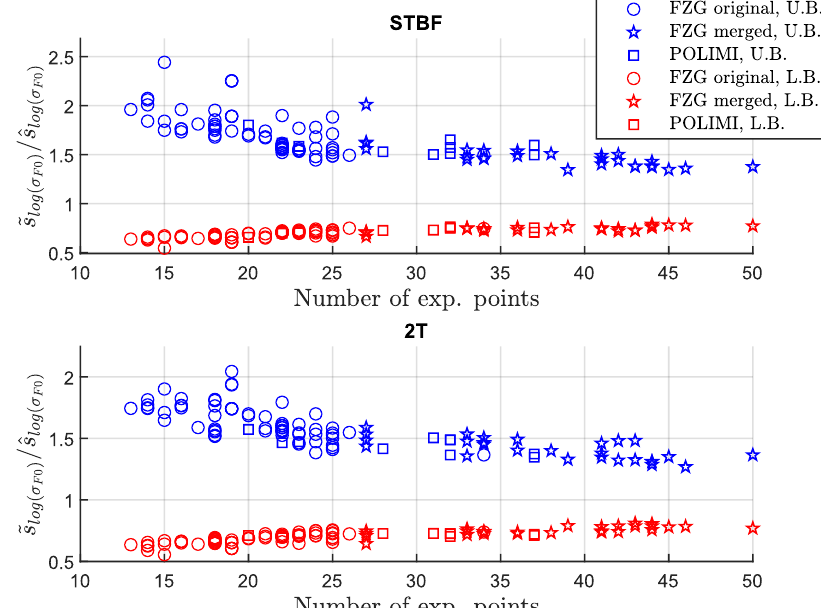
Figure 17. Trend of normalized s log ( σ